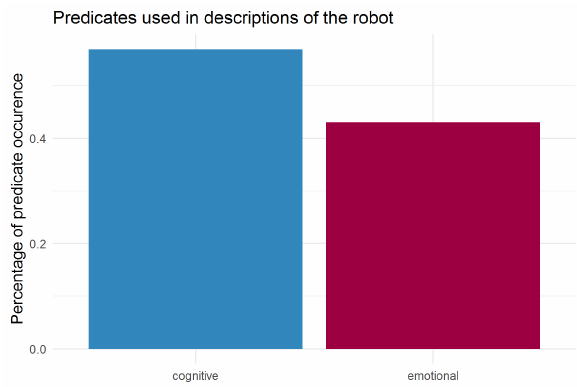
Figure 7: Comparison of categories for cognitive and emotional